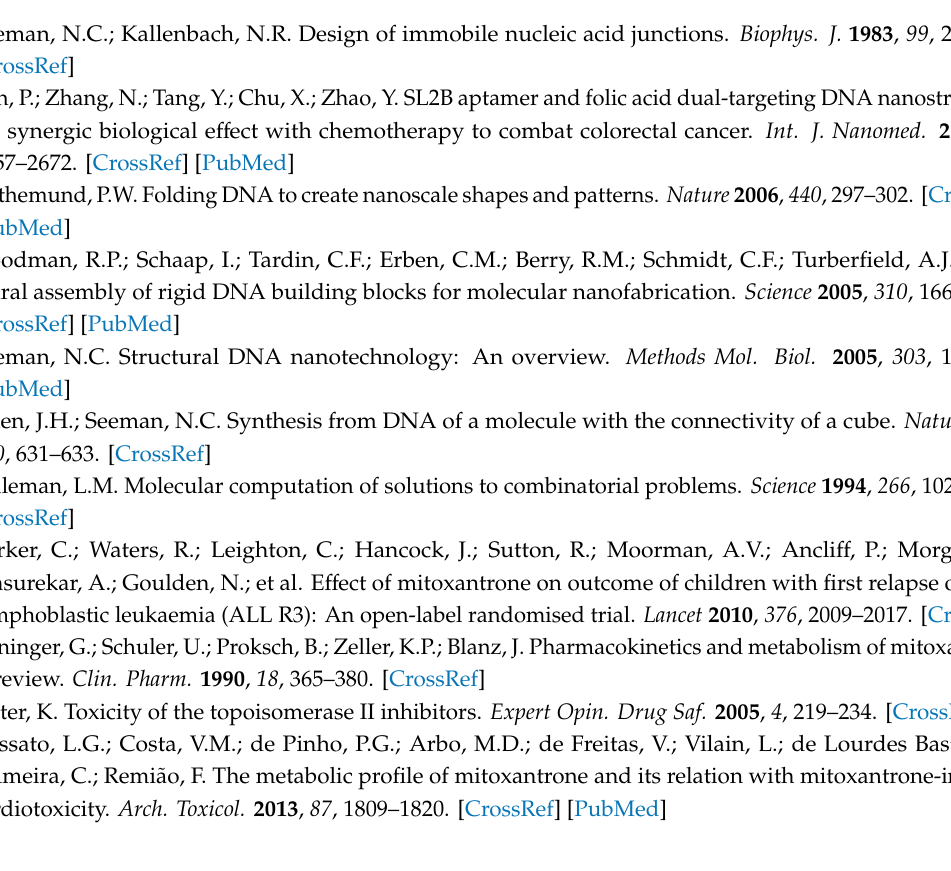
Figure S1: Synthesis of the folate-overhang complement; Figure S2: Co-localization with nuclei in leukemia BALL-1 cells after treatment with varying formulations at 2 h; Figure S3: Induced apoptosis in leukemia K562 cells after treatment with folate-overhung mitoxantrone DNA tetrahedra; Figure S4: Anticancer e ffi cacy in leukemia BALL-1 cell xenografts in nude mice after treatment with folate-overhung mitoxantrone DNA tetrahedra. Survival number of nude mice after treatment with di ff erent formulations; Figure S5: Body weight of nude mice after tumor implantation; Table S1: Base sequences of strands for synthesis of DNA tetrahedra; Table S2: Characterization of the DNA tetrahedra; Table S3: Blood indicators of nude mice after treatment with varying